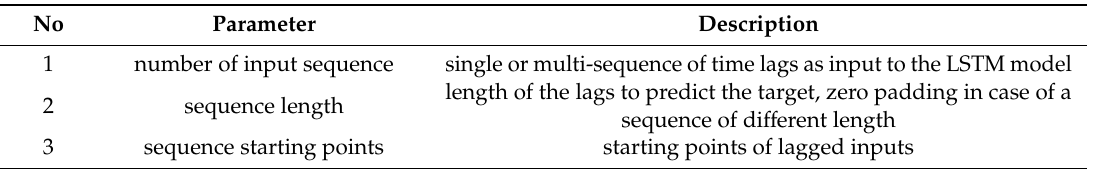
Table 1. Input lag parameters for the LSTM model.